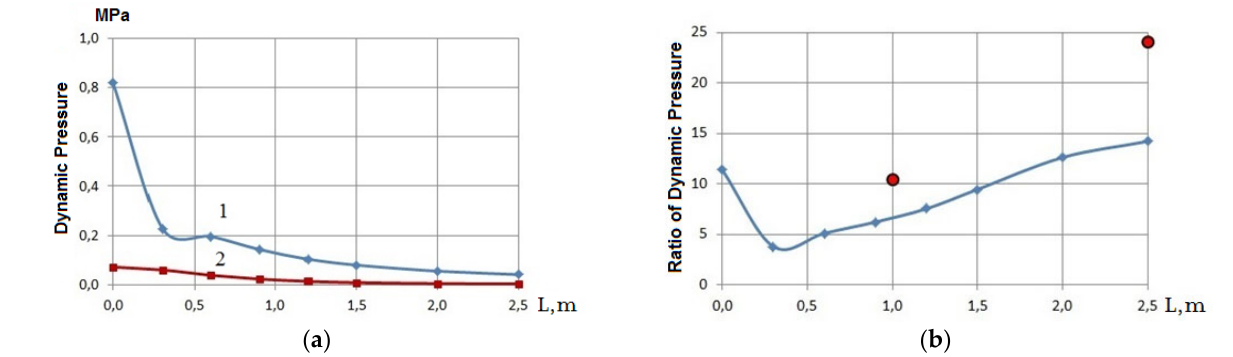
Figure 17. Distribution of the mass-average values of the dynamic pressure over the jet length in calculation: ( a ) 1—P 02 (0) = 2.35 MPa; 2—P 02 (0) = 0.235 MPa; ( b ) the ratio of the dynamic pressure over the jet length. Dots show the ratio of the forces acting on the single tube.